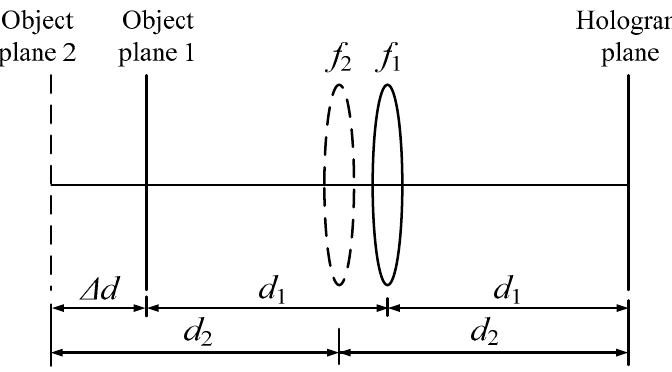
Figure 3. Optical configuration for generating FRT holograms of 3D objects.